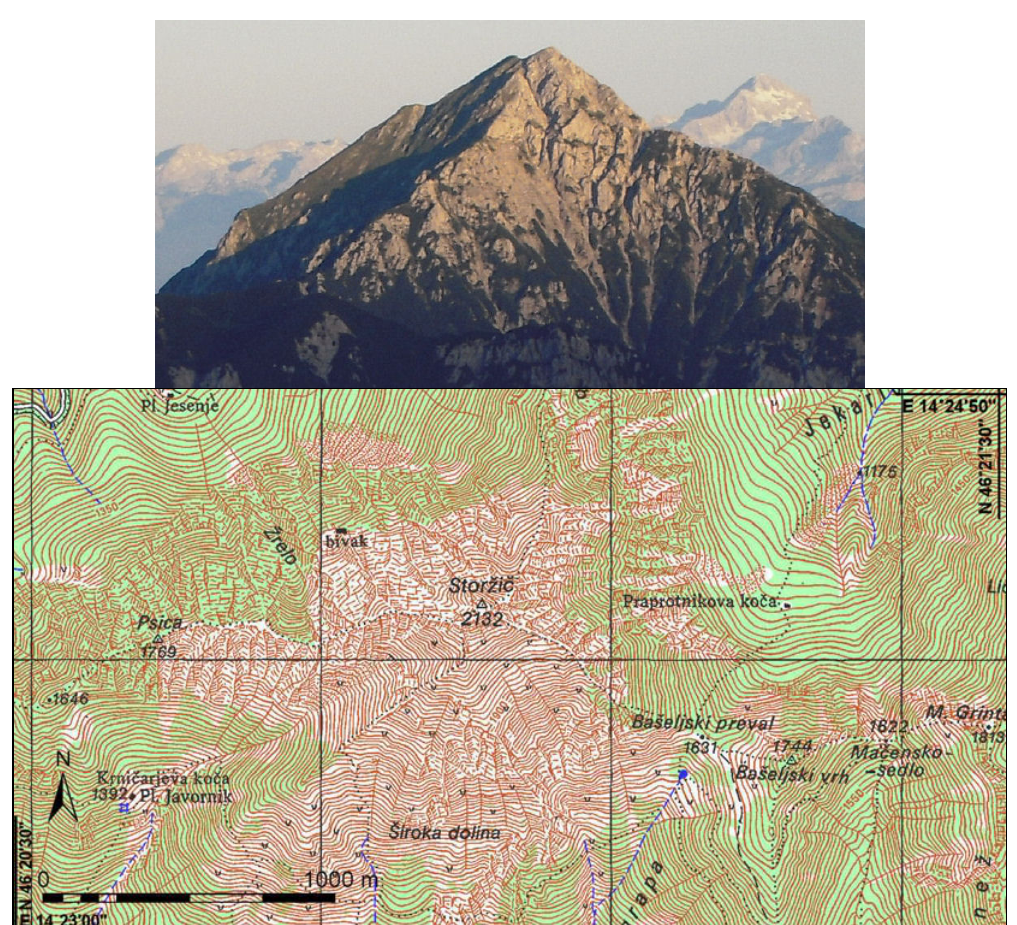
Figure 12. A view of the conical peak of Storži č as seen from Kokrsko sedlo, 10 km east from the peak, with the corresponding insertion of the topographic map DTK 25 below with 1 km gridlines [37]. The peak appears very conical from all